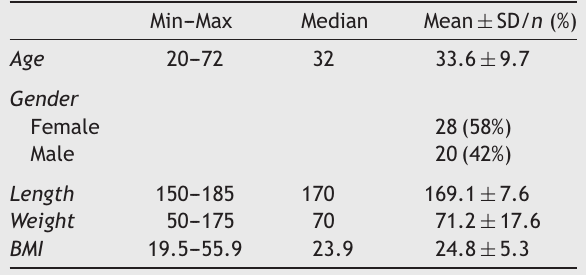
Baseline characteristics of the study